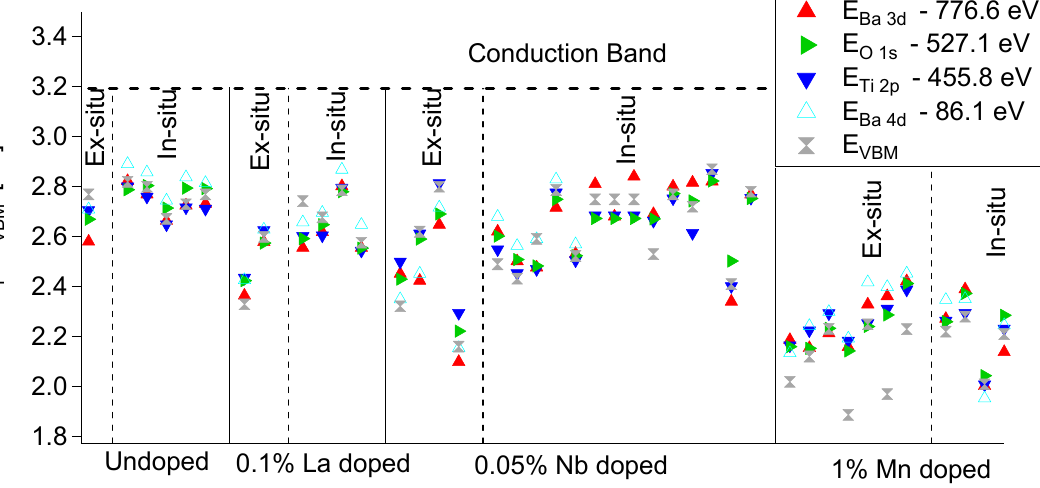
Figure 6. Fermi level position of differently doped BaTiO3 thin samples analyzed directly after deposition without breaking vacuum (in-situ) or after deposition in a disconnected deposition chamber after surface cleaning by annealing in a low-pressure oxygen environment (ex-situ).